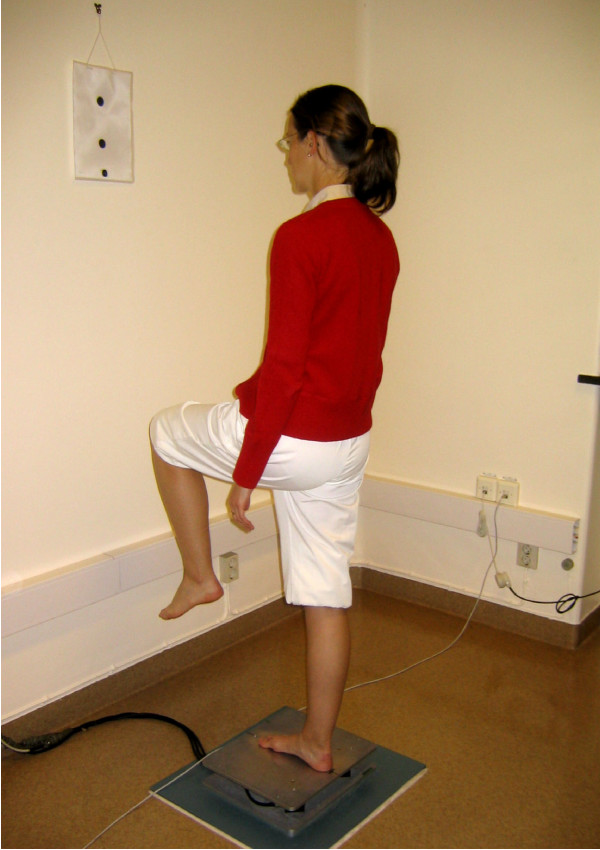
Stabilometry in single-limb stance, tested by means of a strain gauge force plate. A standardized position was used. The subject is a model who did not participate in the study.